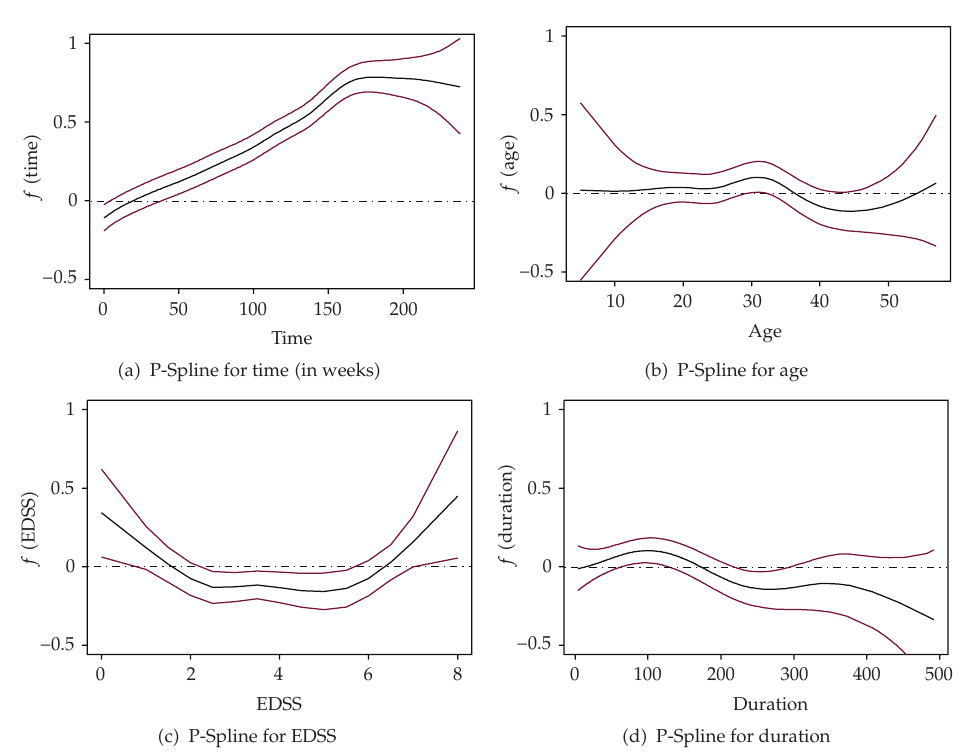
Figure 6: P-Spline posteriors for random intercept models with Gaussian response. Posterior means and confindence interval are